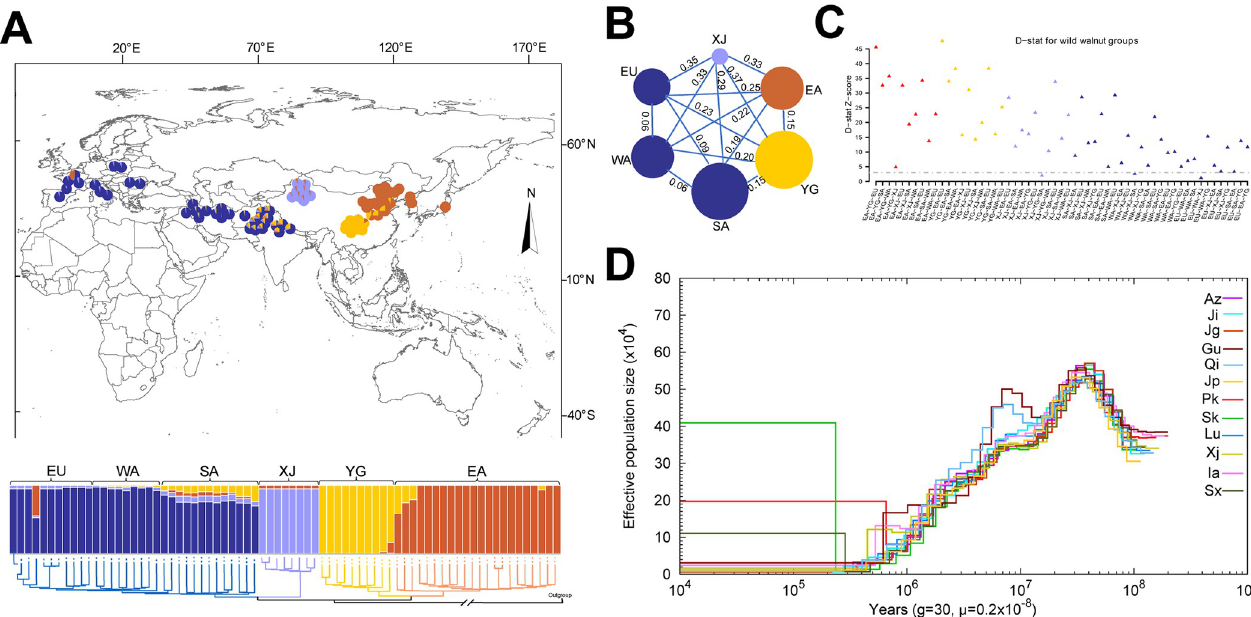
Fig 3. Phylogeny, population structure, diversity, and dynamic history of wild walnuts. (A) Geographic distribution, population structure, and phylogenetic tree analysis of wild Persian walnut accessions plus outgroups. Each of the six regional walnut populations are indicated by different colors. EA: Eastern Asia; YG: Yunnan-Kweichow Plateau; XJ: Xinjiang province; SA: southern Asia; WA: western Asia; EU: Europe. The basemap and distribution of all sampling points were plotted in ArcGIS v10.2 (ESRI Inc., Redlands, California, USA). The world map was downloaded from the Natural Earth (https://www.naturalearthdata. com/downloads/10m-cultural-vectors). The grey line indicates the country region border shape in the map. (B) Summary of nucleotide diversity ( θπ ) and population divergence ( F ST ) across groups. The size of each circle represents the nucleotide diversity ( θπ )for the group, and values on the line between pairs indicate the population divergence ( F ST ). (C) Comparisons among wild Persian walnut groups (EA, YG, XJ, SA, WA, and EU) based on D statistics. The grey dotted line indicates where a Z-score is more than 3. (D) Pairwise sequentially Markovian coalescent (PSMC) estimates of the changes in the effective population size over time for 12 individuals of Persian walnut. Each line represents one individual. 10 � 6 = 1.0 Ma; Persian walnut Ne curves converged 1.0 million years ago, probably reflecting the time when all sources of J . regia last shared a common ancestor. “Az”-Landrace from Azerbaijan; Ji-Cultivar Jiling province, China; Jg-cultivar from Beijing, China; Gu-wild walnut from Guizhou province, China; Qi-wild walnut from Qinling mountains, China; Jp-landrace from Japan; Pk-wild walnut from Pakistan; Sk-landrace from South Korea; Lu-cultivar from Shandong province, China; Xj-cultivar from Xinjiang province, China; Ia-wild walnut from Iran; Sx-wild walnut from Shaanxi province, China. https://doi.org/10.1371/journal.pgen.1010513.g003 (Figs 3A and S3). The XJ population showed the lowest gene flow with other walnut popula- tions (Fig 3C; S3 Table). We detected the highest genetic differentiation ( F = 0.33) value ST between XJ samples and samples from other populations; the lowest F values were found ST between WA and SA and between WA and EU (Fig 3B). The PCA results showed that the XJ